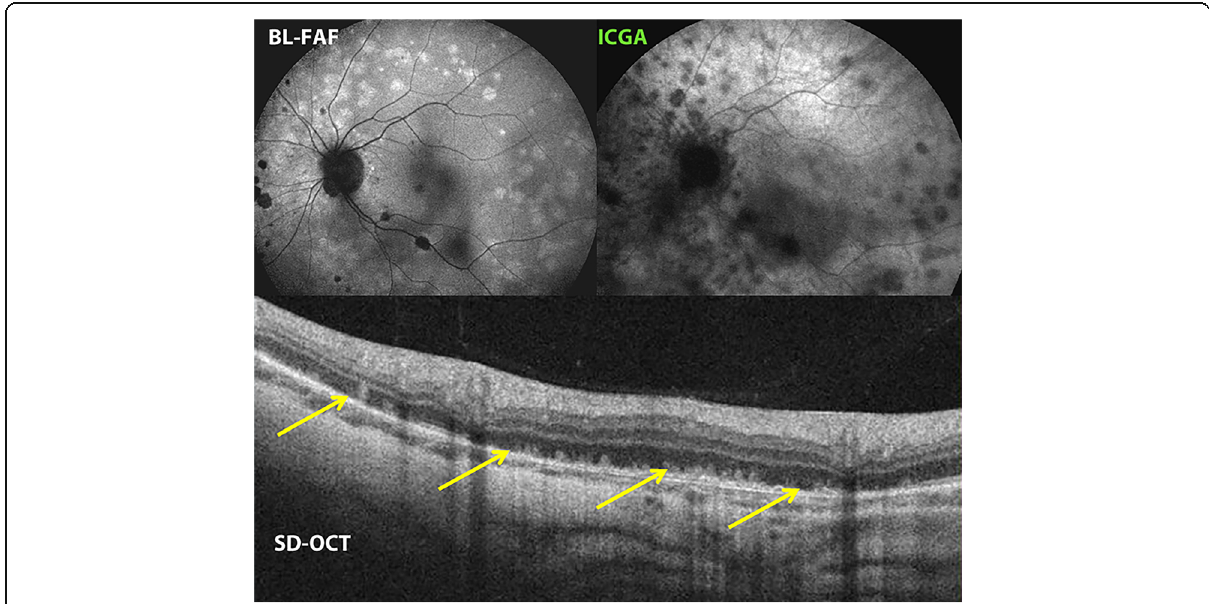
Fig. 5 Multifocal choroiditis (MFC). BL-FAF, ICGA and SD-OCT. Loss and/or damage of the photoreceptor outer segments (bottom picture SD- OCT, yellow arrows), corresponding to the areas of BL-FAF-hyperautofluorescence (top left) and to the areas of ICGA hypofluorescence (top